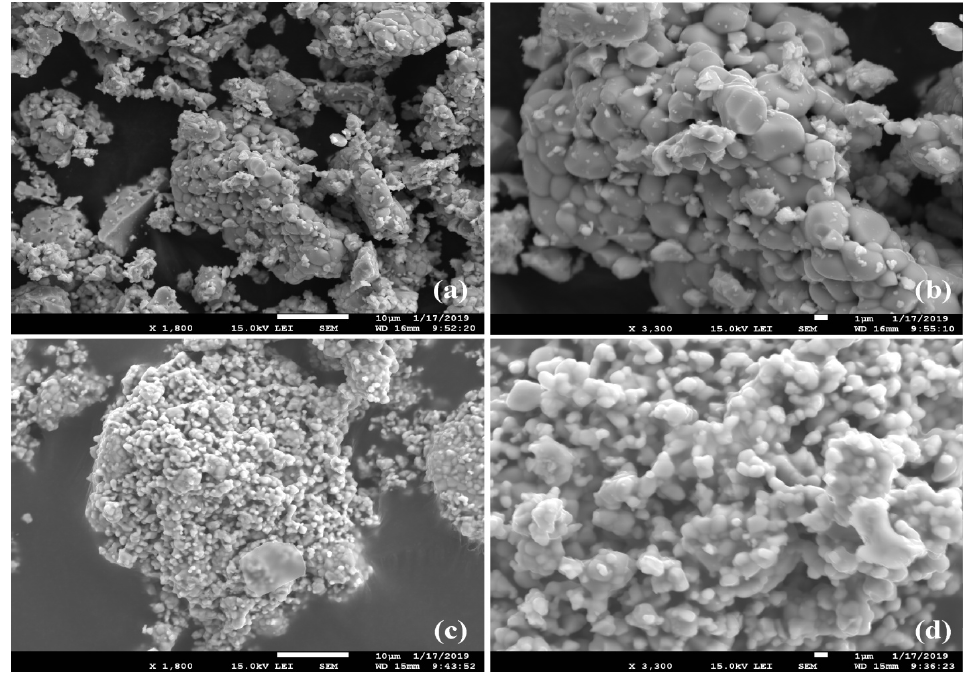
Figure 2. SEM images of ternary structured ( a , b ) ZS–2, and ( c , d ) ZT–2 catalysts at the same magnifications ( a ) and ( c ) ×1800 and ( b ) and ( d ) ×3300 for comparison.